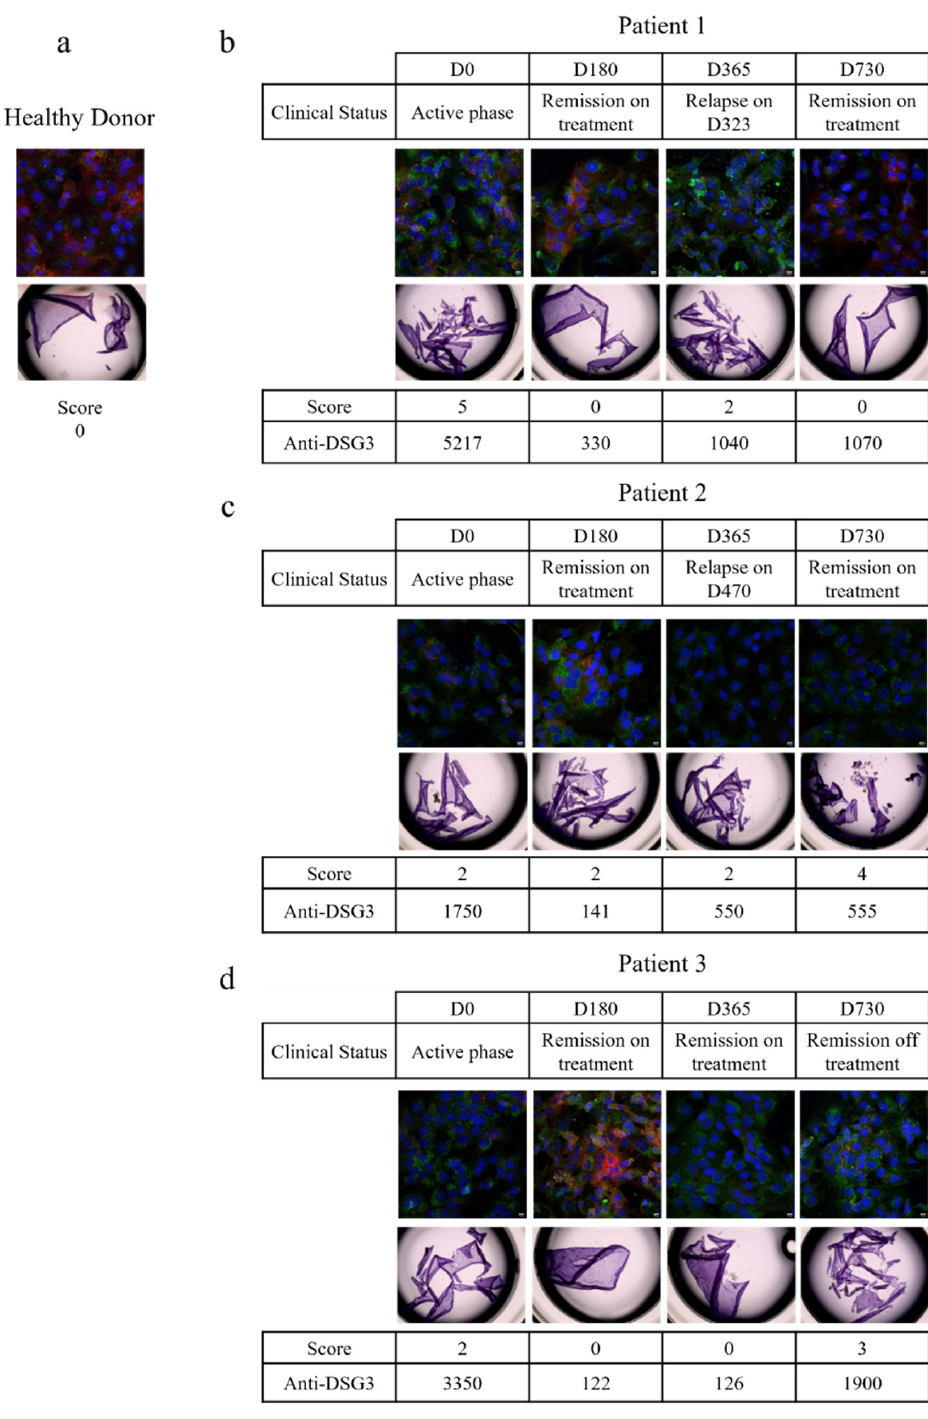
Figure 3. Longitudinal study of IgG pathogenicity. Pathogenicity of IgG from healthy donors ( a ) and three different pemphigus patients ( b – d ) were studied longitudinally by dispase-based dissociation assay and immunofluorescence. For the dispase-based assay, monolayers of HaCaT cells were treated with 62.5 µg/mL of purified IgG from healthy donors or pemphigus patients for 24 h. For immunofluorescence, cells were treated with 62.5 µg/mL of purified IgG from healthy donors or pemphigus patients for 20 h. Then cells were fixed and immuno-stained for DSG3 (red) and flotillin-2 (green). DAPI was used for nuclear staining (blue). Healthy donors: n = 5; patients: n = 3. Five images were taken for each condition, in two independent experiments. Pictures were taken with a Leica SP8-UV confocal microscope magnification ×40.